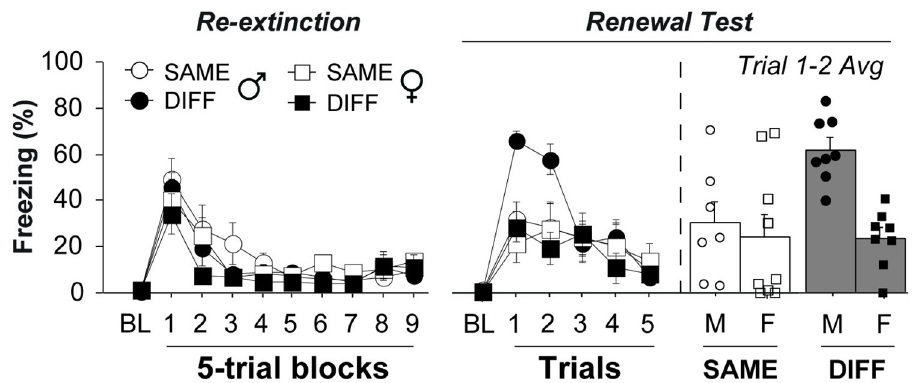
Fig 3. Male ( ) but not female ( ) Wistar rats exhibit renewal of extinguished fear. Freezing data showing that male and female Wistar rats displayed similar levels of fear during a second extinction session after the prior extinction retrieval test (left). However, only male rats displayed fear renewal the following day when presented the extinguished CS in a novel context (DIFF, right) relative to animals tested in the extinction context (SAME). This was particularly evident during the first two trials of testing. All error bars represent ±